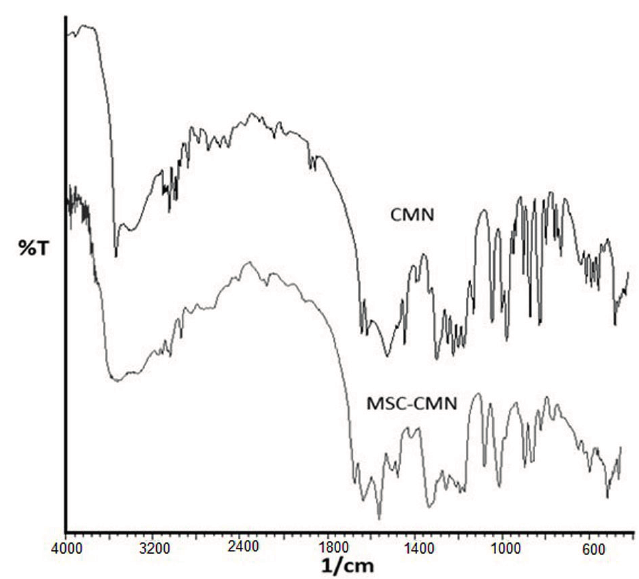
Figure 6. FTIR spectra of CMN and MSC